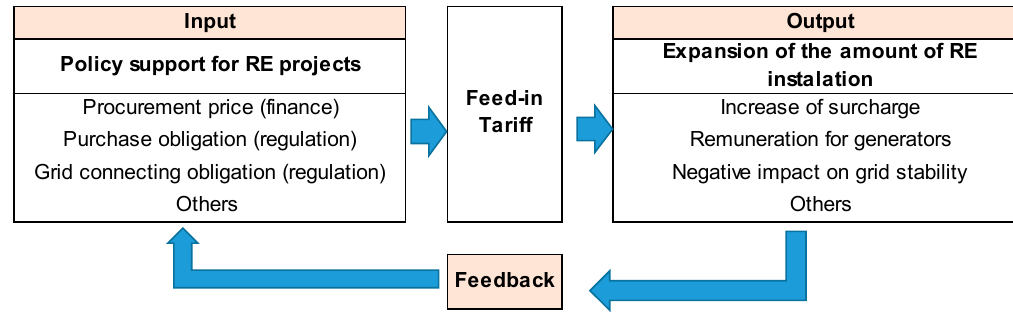
Figure 2. Conceptual Feedback Control for the FiT.